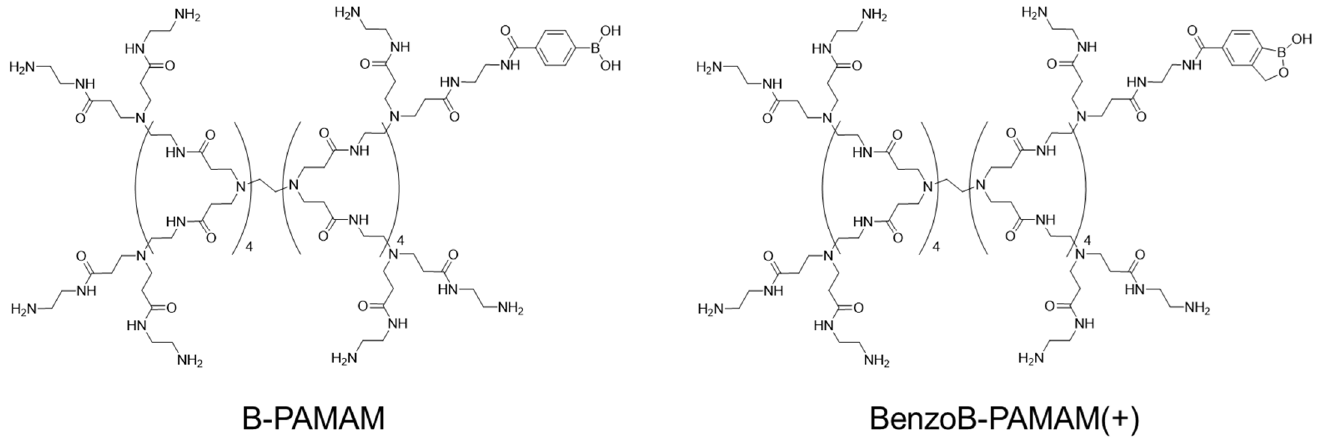
Figure 2. Structures of boronic acid-based PAMAM dendrimer probes.